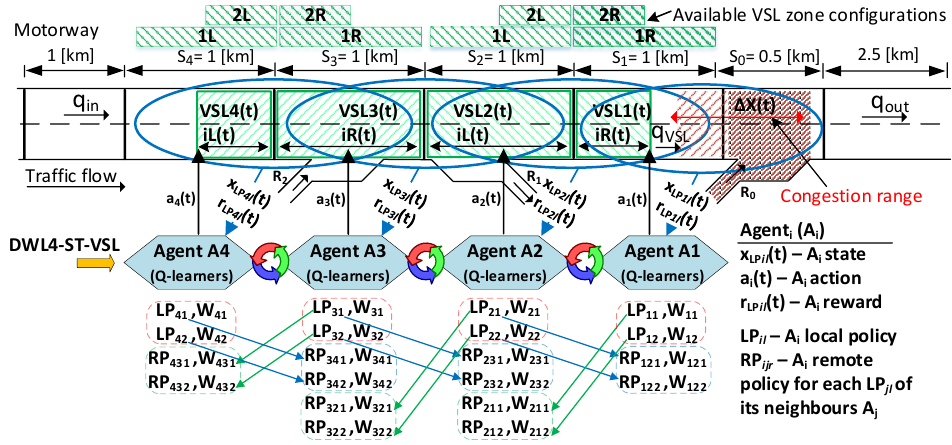
Figure 2. DWL4-ST-VSL configuration